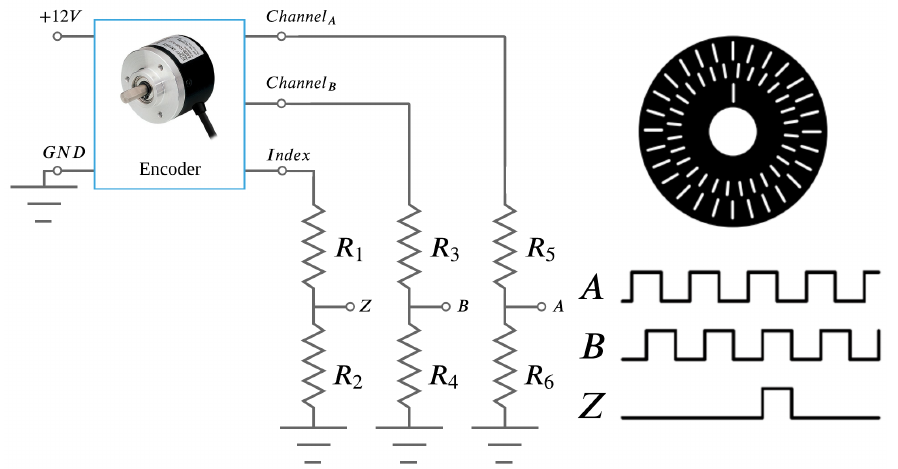
Figure 11. Encoder signal conditioning